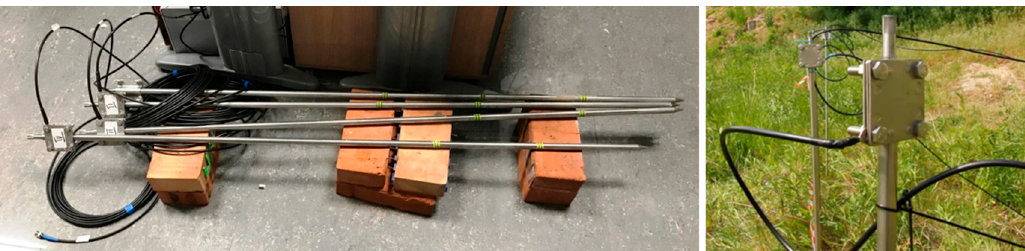
Figure 7. Electrodes in TERT device.